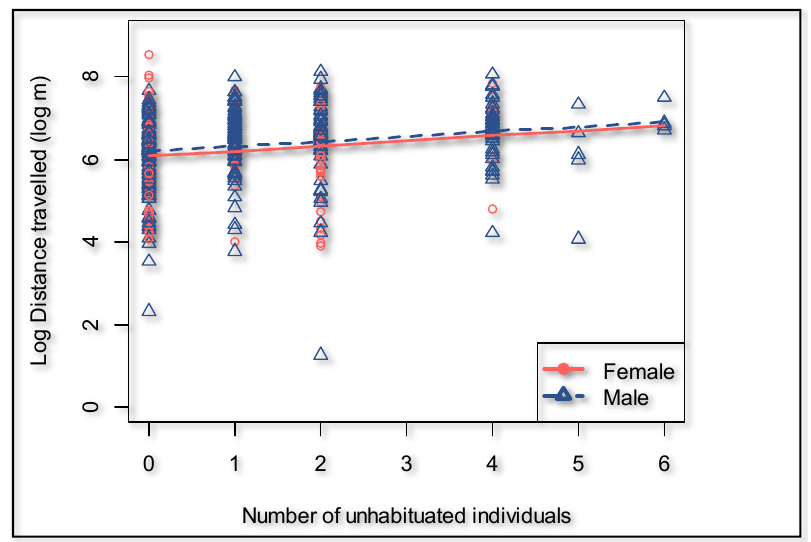
Figure 5. Effect of the presence of unhabituated giraffes on the distance traveled by the focal individuals when human observers are present. Table 2. Average distance traveled (m) per hour per individual.